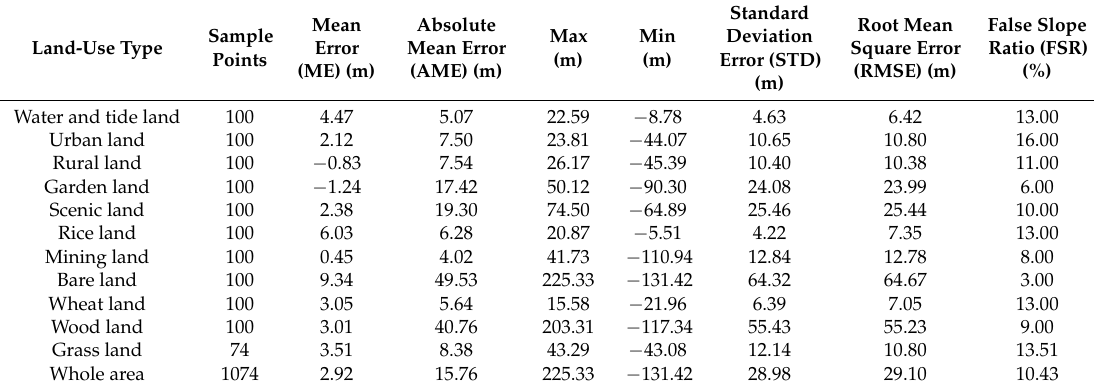
Table 2. Statistical measures of Dorig (the difference between the original GDEM2 and the first sample set).